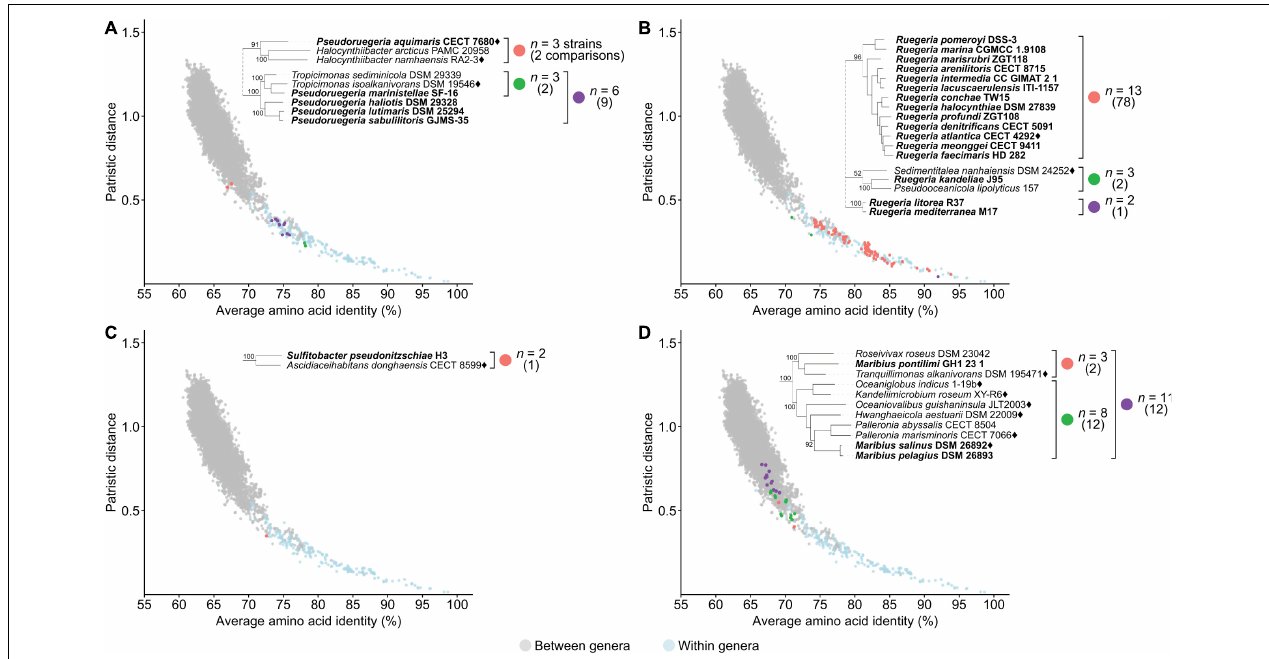
FIGURE 5 | Dot plot for patristic distance (PD) against average amino acid identity (AAI) highlighting the comparisons of representative polyphyletic genera (A) Pseudoruegeria , (B) Ruegeria , (C) Sulfitobacter , (D) Maribius , and closely related organisms. PD and AAI comparisons for clades of interest are shown in orange, green, or purple. PD and AAI comparisons for all between (gray) or within (blue) recognized monophyletic genera are included as reference. The number of strains ( n ) is indicated for each clade of interest, and the number of relevant comparisons is shown in parentheses below. The corresponding phylogenetic trees are subsets of the core-genome tree ( Figure 2 ). Names in bold are organisms of polyphyletic genera of interest. Diamonds after the names indicate the type species.